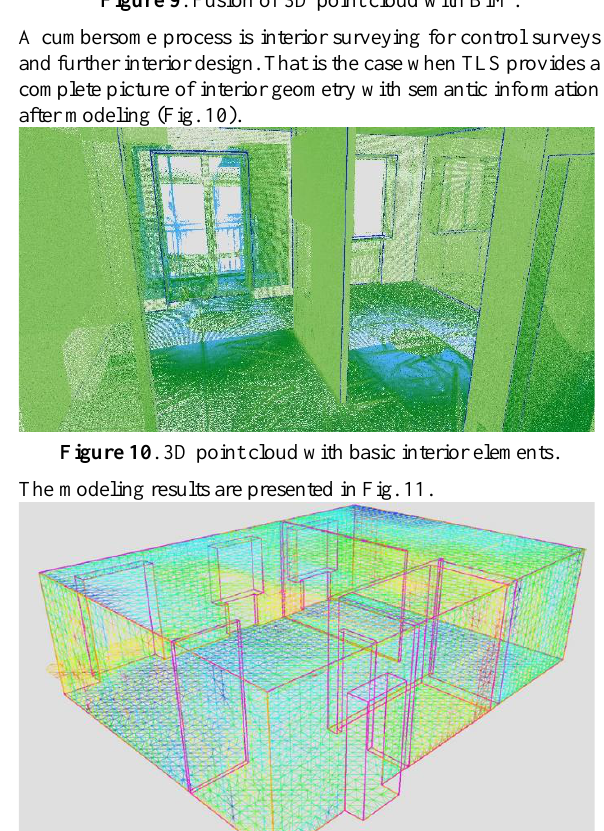
Figure 14 . Comparison of the highway top layer before and after cutting